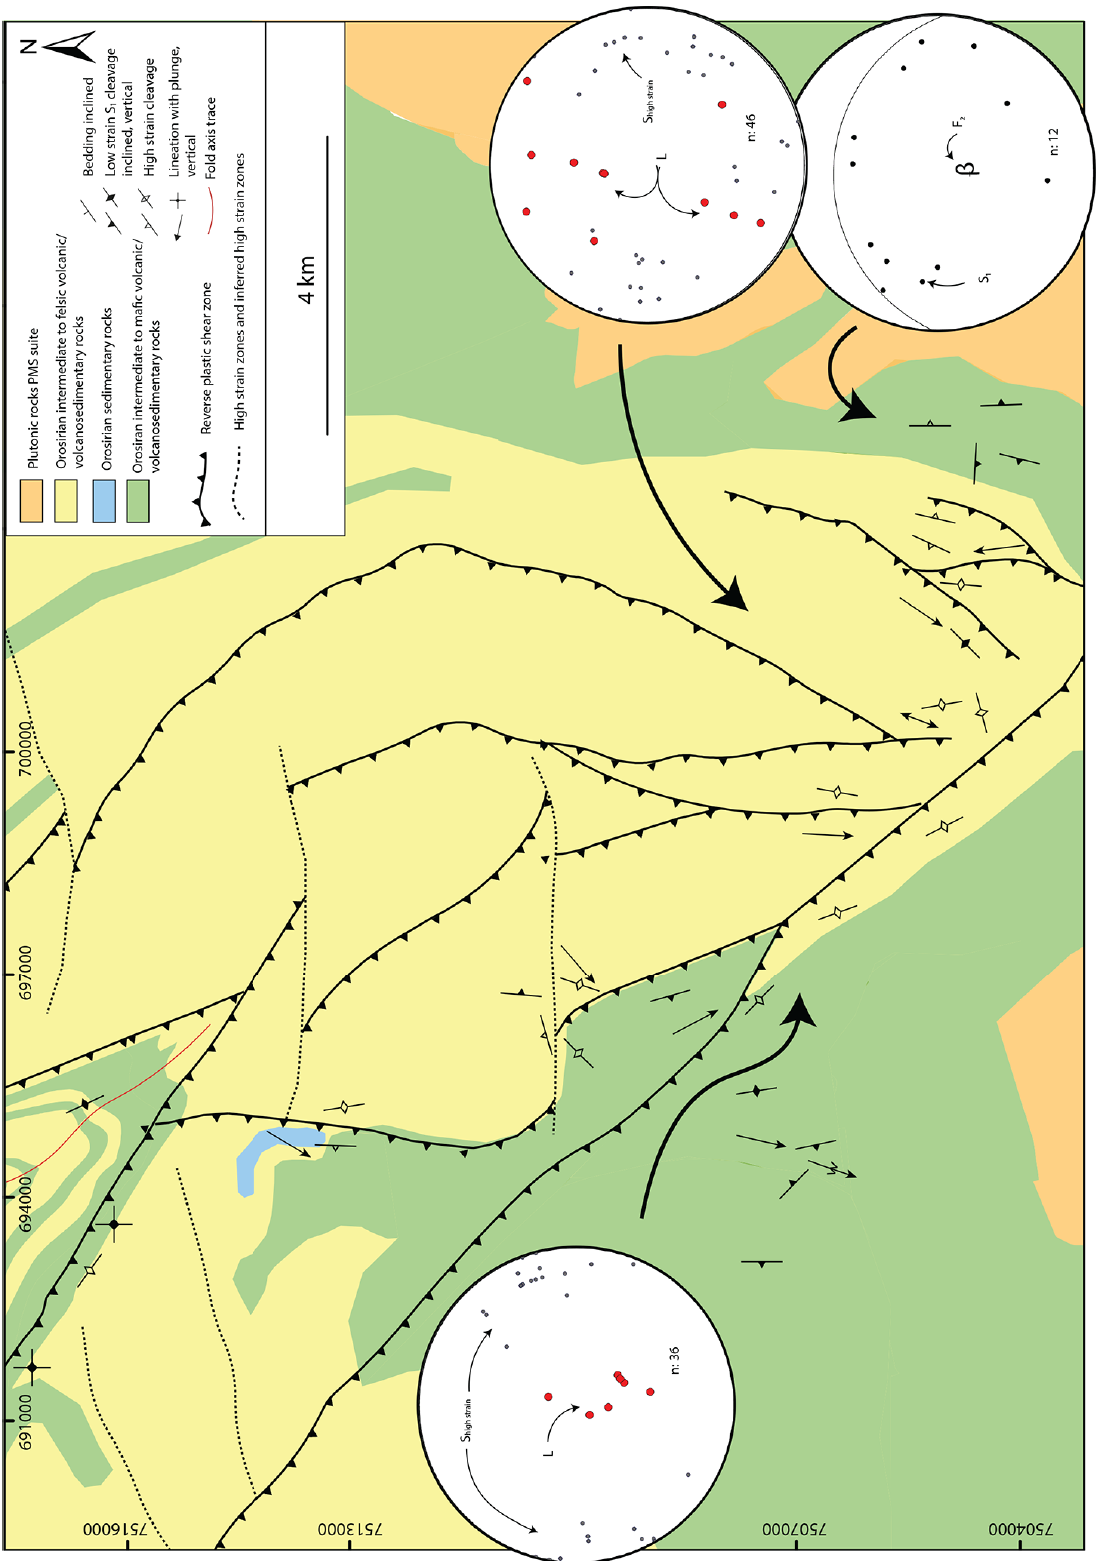
Figure 12. Geological map of the Kaitum West key area. Modified after Offerberg (1967). Coordinates: